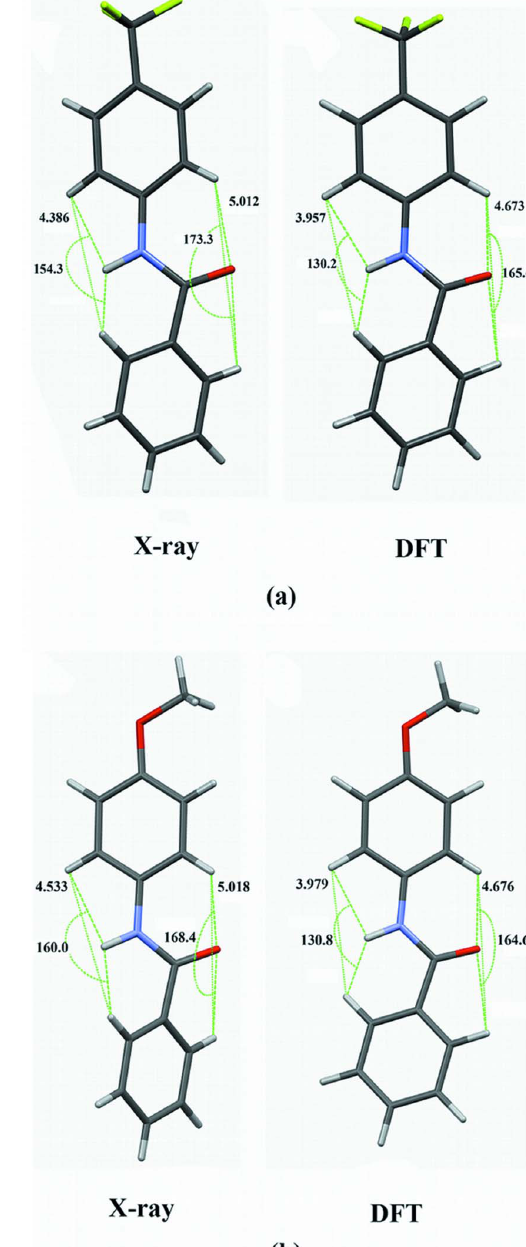
and shown in Fig. 4. There is only one type of N—H (cid:3) (cid:3) (cid:3) O interaction in both crystal structures, in the direction parallel